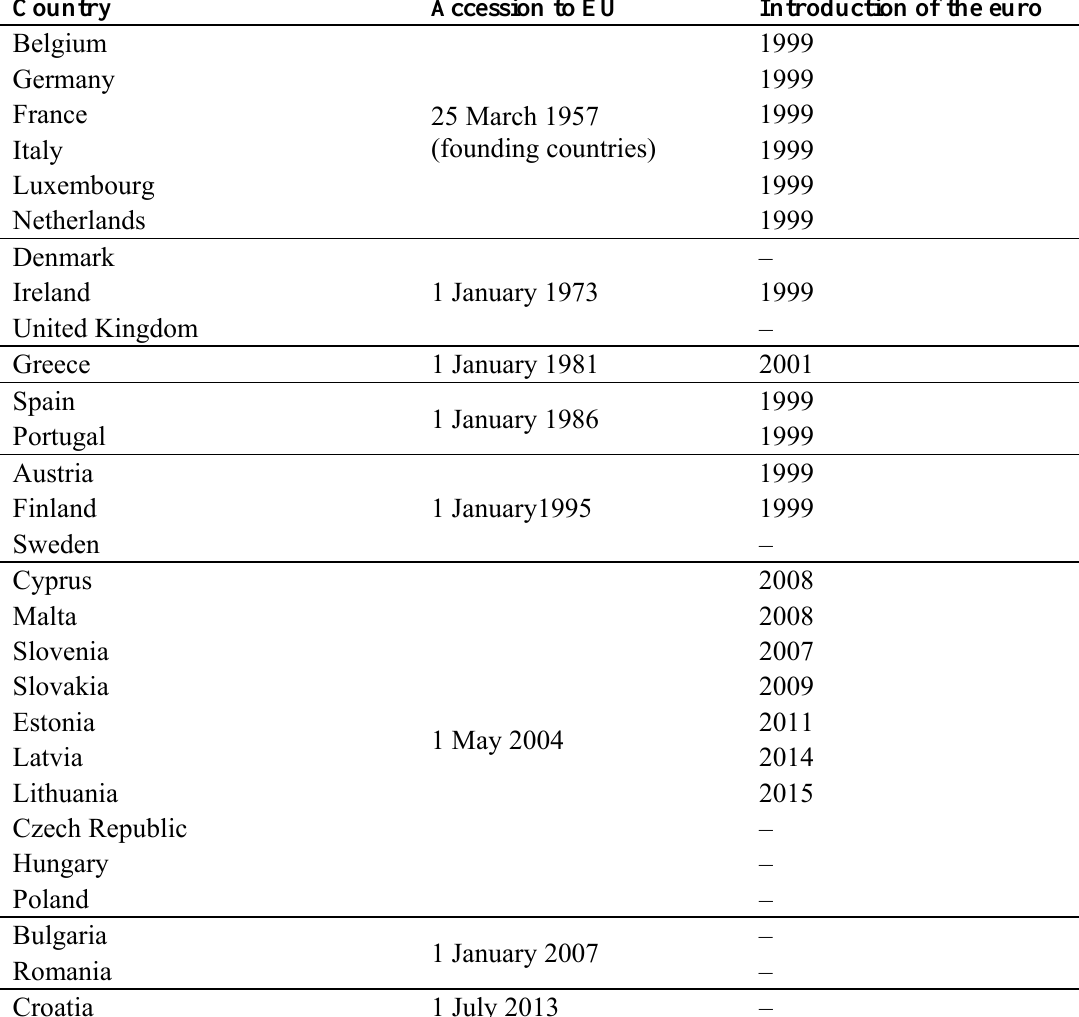
Table 1 : Foundation and enlargement rounds of the EU and the euro